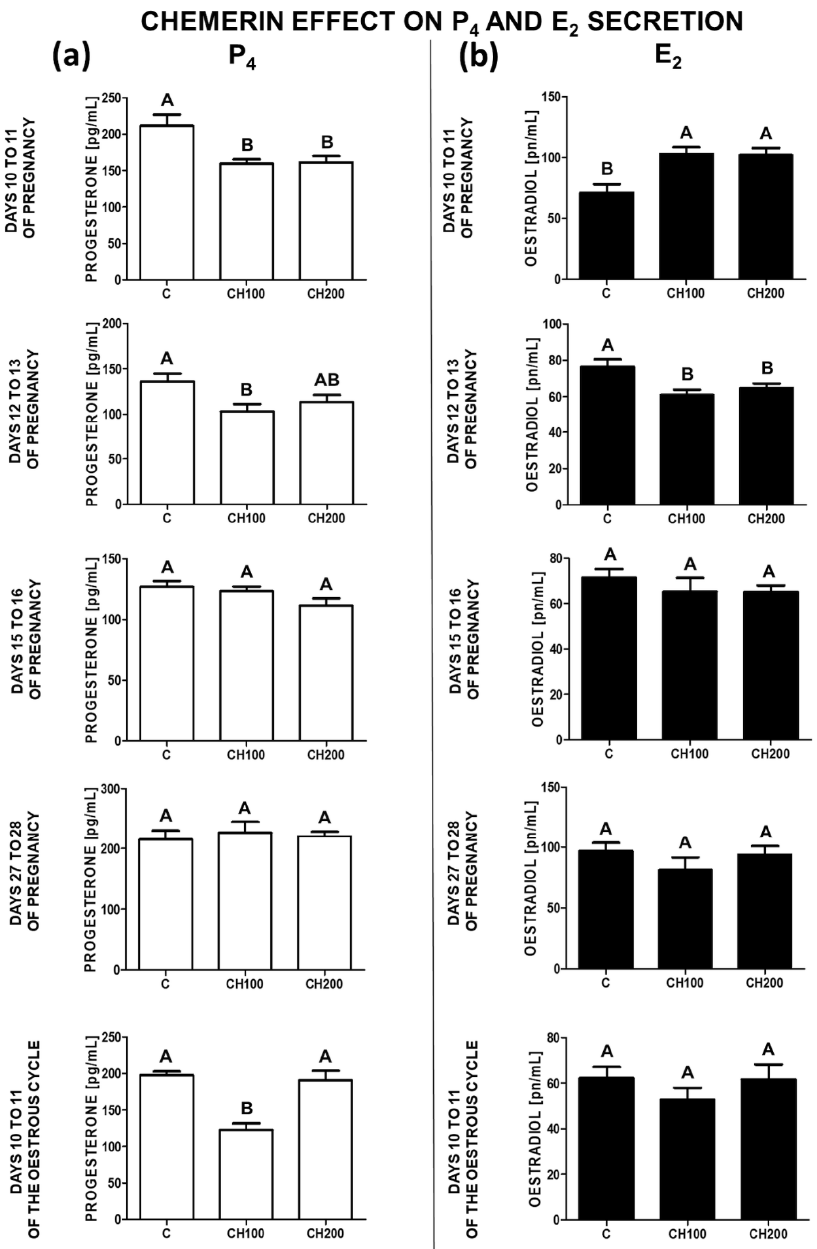
Figure 1. The effect of chemerin on P 4 and E 2 secretion. The influence of chemerin (100, 200 ng/mL) on the secretion of progesterone (P 4 ; ( a )) and oestradiol (E 2 ; ( b )) by the in-vitro-incubated endometrial tissue explants collected from pigs on days 10 to 11, 12 to 13, 15 to 16, and 27 to 28 of pregnancy, and on days 10 to 11 of the oestrous cycle. The steroid hormone concentrations in culture media were evaluated using radioimmunoassay analysis. Data are presented as the mean ± standard error of the mean ( n = 5). Bars with different letters are significantly different at p < 0.05.